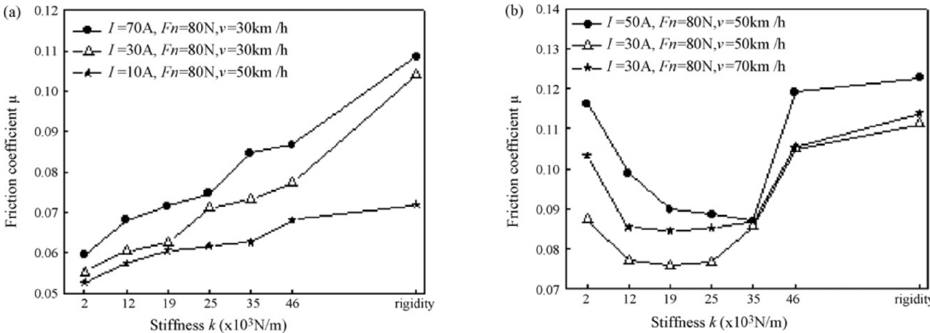
Figure 9. Variation in the friction coefficient with spring stiffness: ( a ) at low speed or low current, ( b ) at high speed or high current [62].